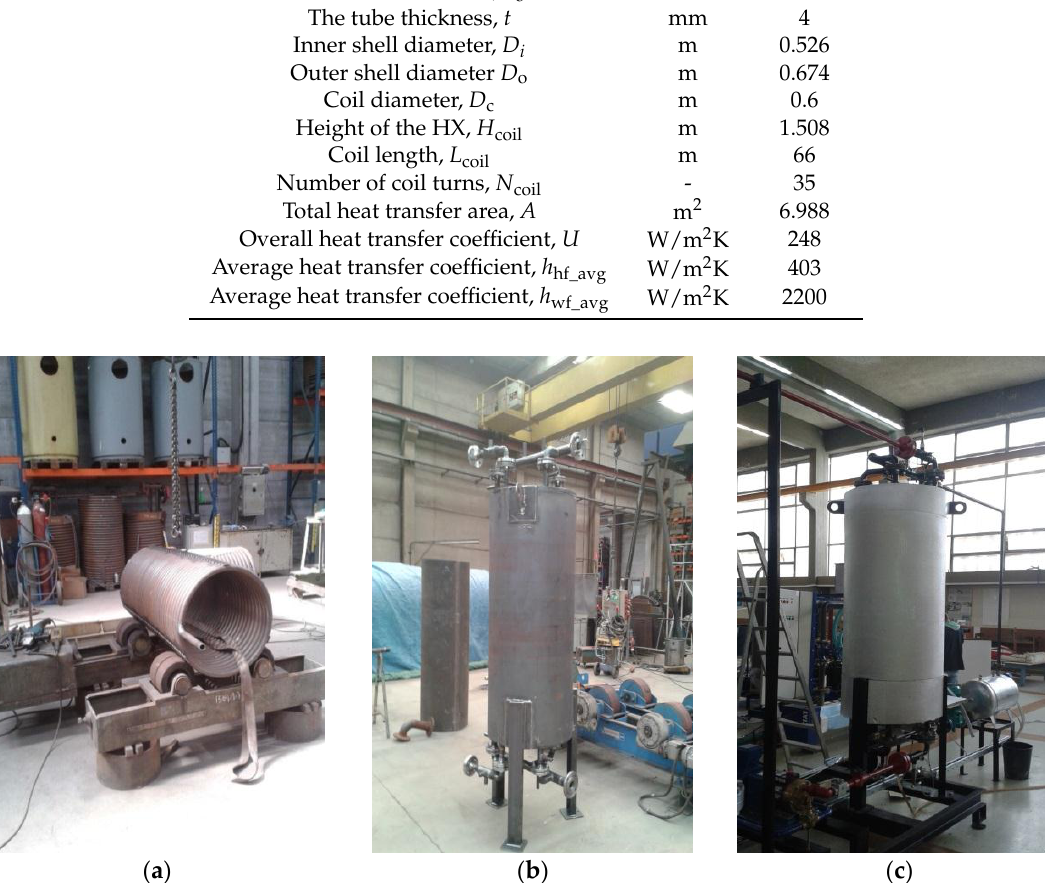
Figure 5. Construction of the helical coil heat exchanger: ( a ) helical coil; ( b ) manufactured heat exchanger; and ( c ) heat exchanger installed in the ORC installation.